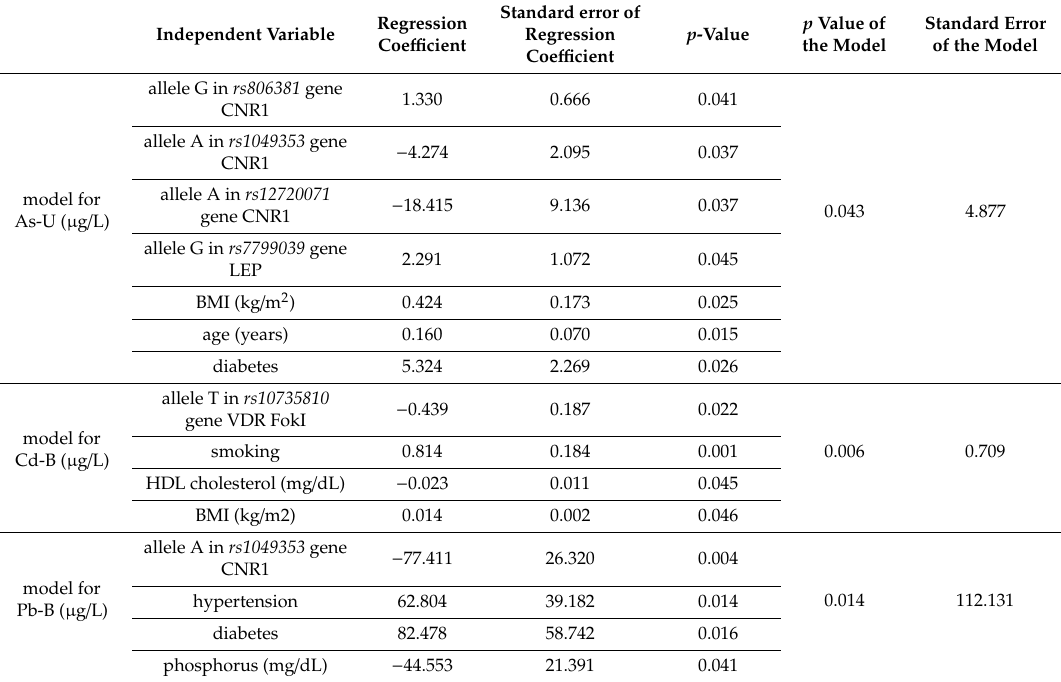
Table 9. Results of estimation for the final model obtained from multivariate regression